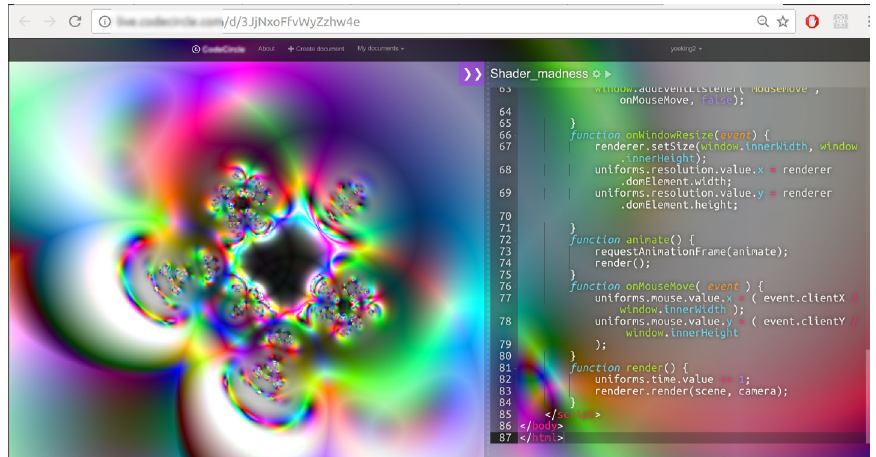
Fig. 1. Screen shot of the IDE. The code for the program can be edited on the right. The output of the running program can be seen on the left. The code editing panel is made opaque when editing so the code can be clearly